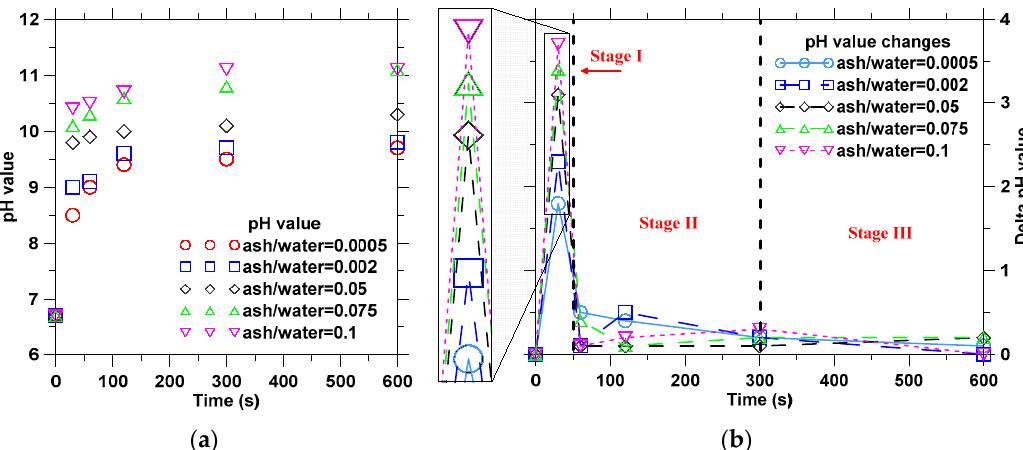
Figure 2. The pH value changes of suspensions with plant ash lixivium: ( a ) pH and ( b ) change of pH with time.